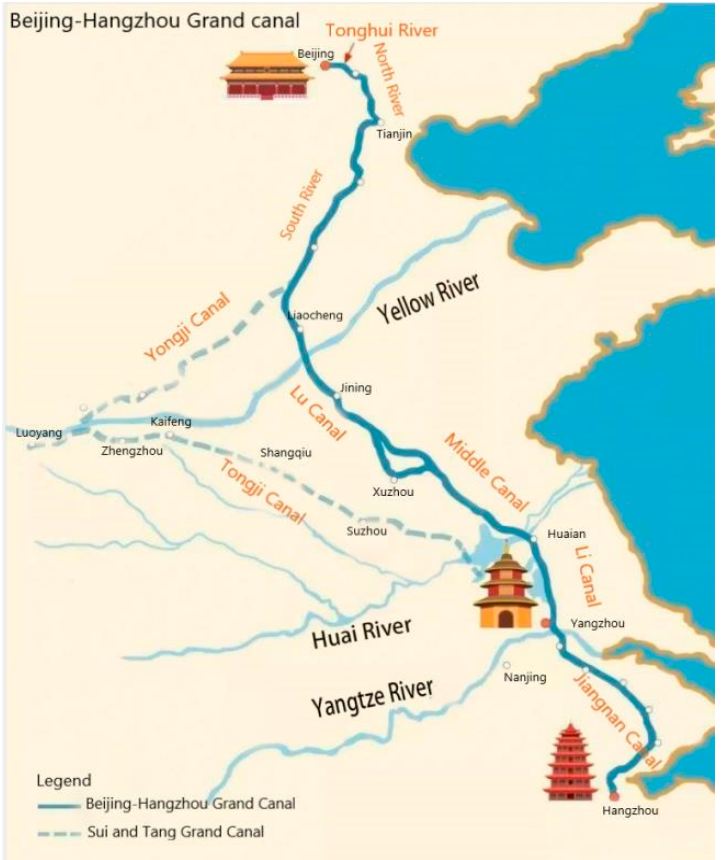
Figure 7. The Beijing–Hangzhou Grand Canal replaced the Sui–Tang Grand Canal in the Yuan Dyn- asty; as a result, Kaifeng was finally